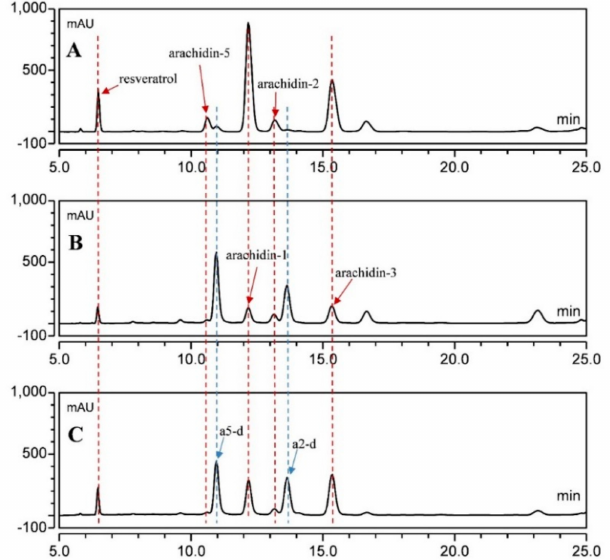
Figure 6. Comparison of secreted stilbenoid profiles between wild Arachis and cultivated peanut hairy root cultures. HPLC chromatograms of extracts from the medium of hairy root cultures of ( A ) peanut cv. Hull line 3, ( B ) A. duranensis line AdB5 and ( C ) A. ipaensis line AiE4 after 192 h of elicitation treatment. The extracts of lines AdB5 and AiE4 were concentrated 2-fold before HPLC analysis. All chromatograms were monitored at 340 nm.